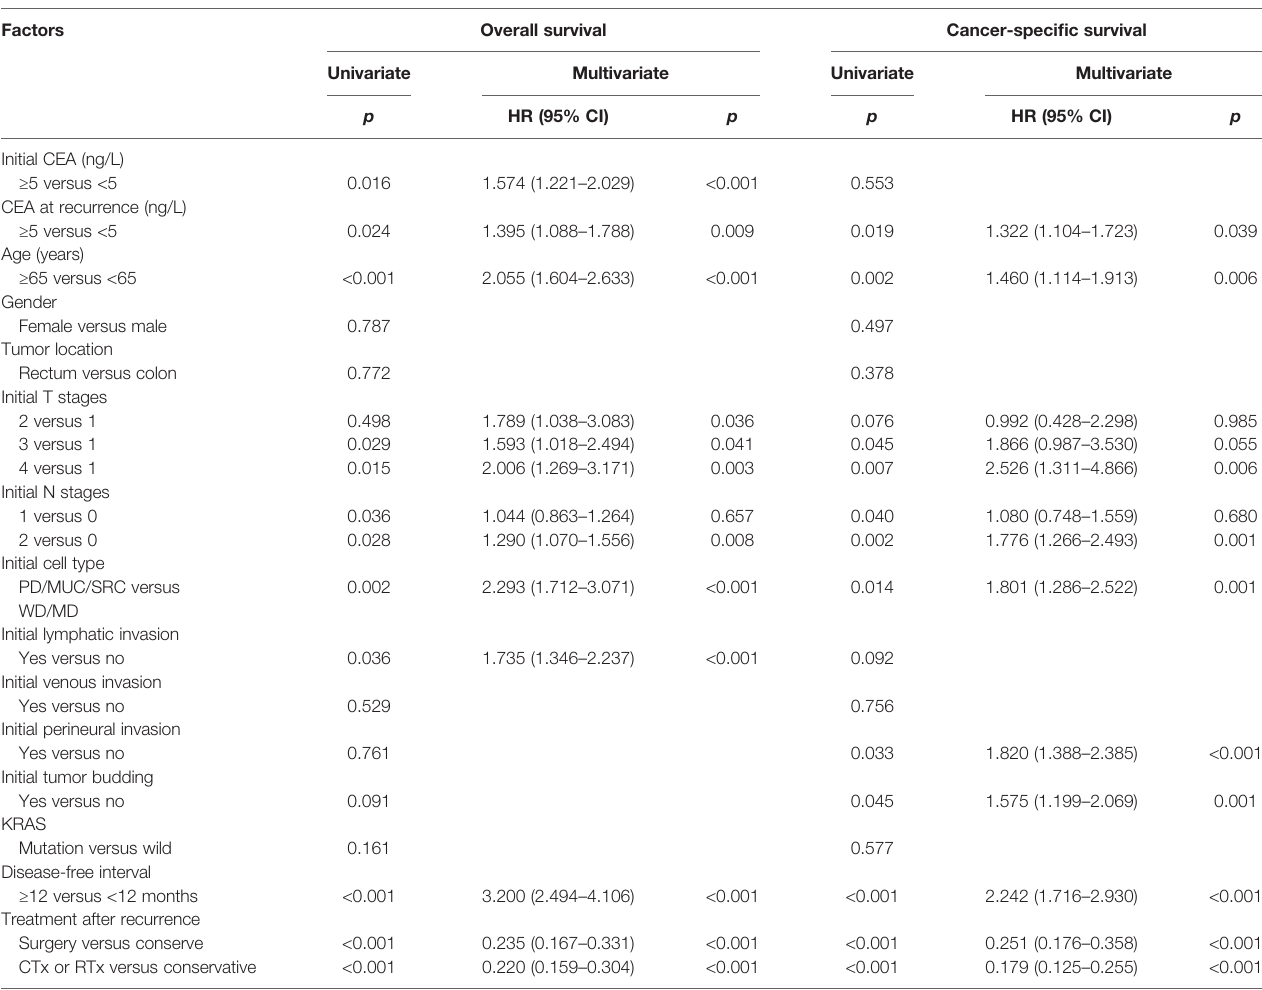
TABLE 2 | Prognostic factors of survival for matched